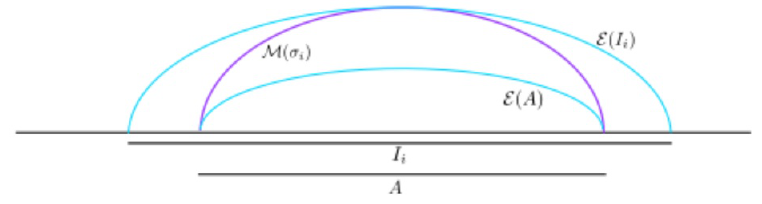
Figure 5 . If a marginally trapped surface (or one of its approximating curves) (cid:27) i ( A ) lies outside the corresponding entanglement wedge E ( A ), we can continuously deform our boundary to larger regions, until at some point the entanglement wedge just touches the wedge associated with (cid:27) i . This results in a